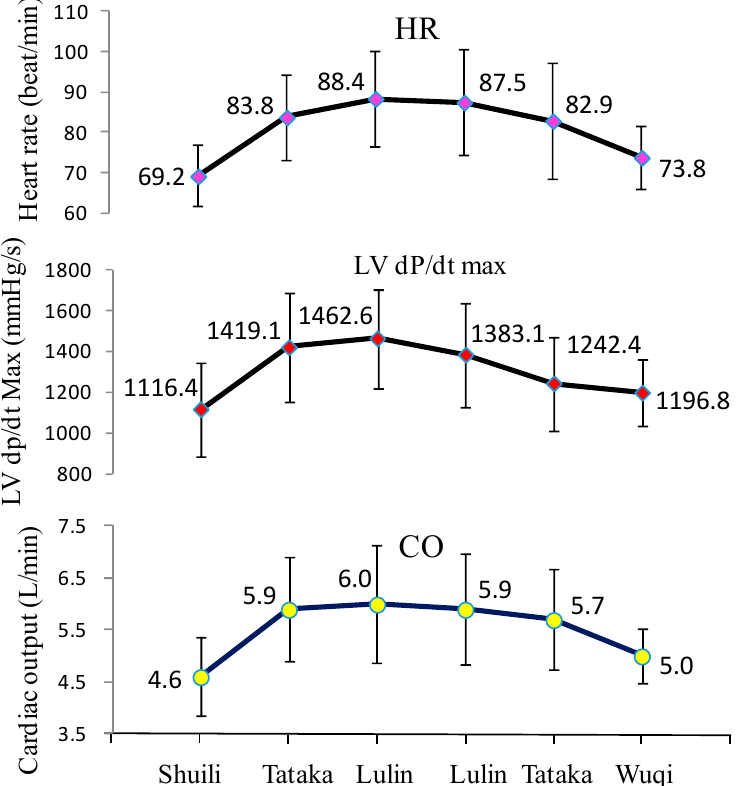
Figure 4. Variational comparison of the oxygen saturation rate and cardiac function after short-term exposure to high altitudes upon return to low altitudes.